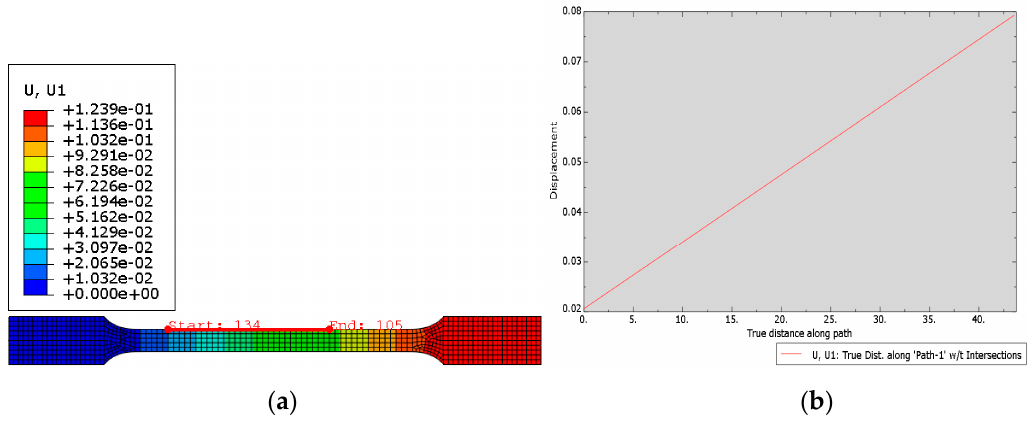
Figure 18. ( a ) Displacement map; ( b ) Plot from the path for sample with lamination angle ± 60 ◦